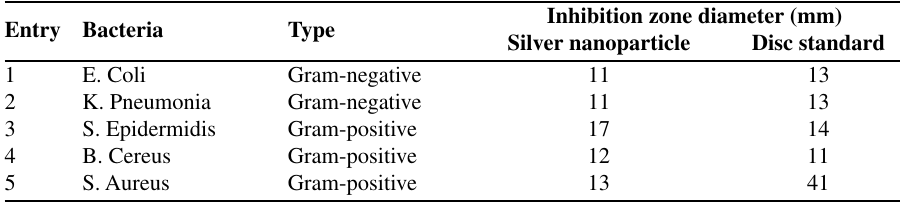
Table 1. Average of inhibition zones synthesized silver nanoparticles with Date fruit extract. Entry Bacteria